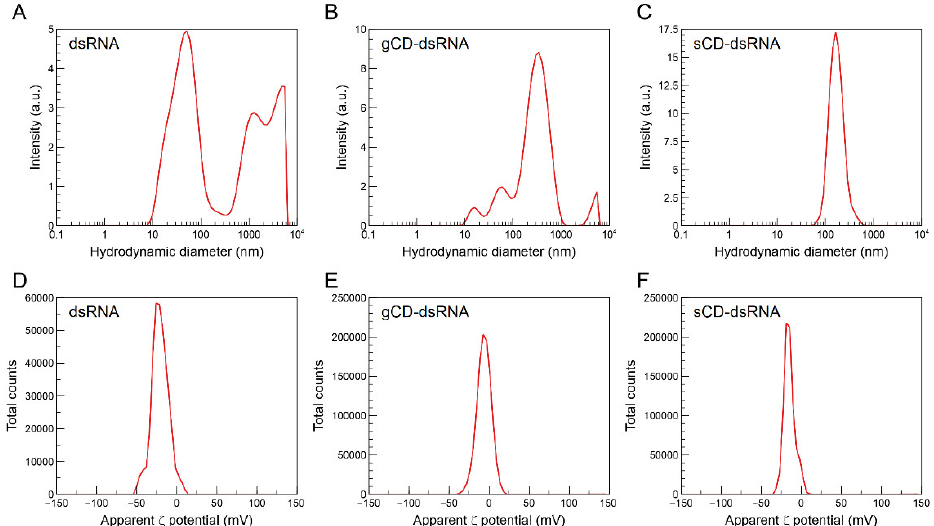
Figure 5. Distribution of hydrodynamic diameters ( A – C ) and apparent ζ potential distributions ( D – F ) and for the pristine dsRNA and the gCD-dsRNA and sCD-dsRNA nanocomposites.